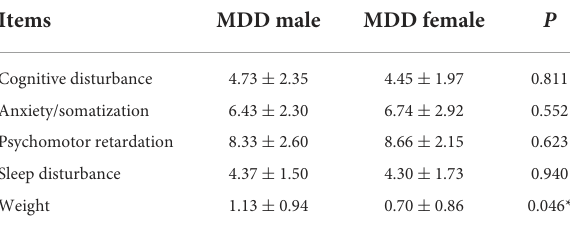
TABLE 2 Data of the five clinical factors in HAMD of male and female MDD.